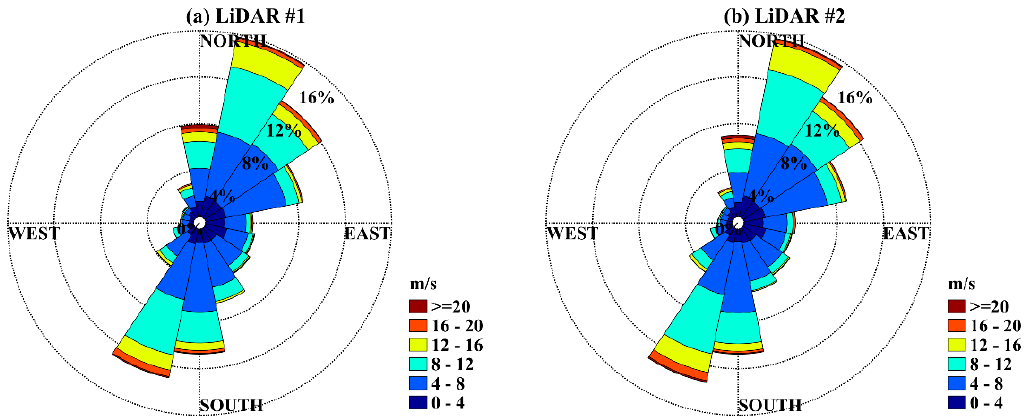
Figure 9. Comparison of wind roses for LiDAR #1 and LiDAR #2 at a height of 100 m from the LiDAR installation levels.